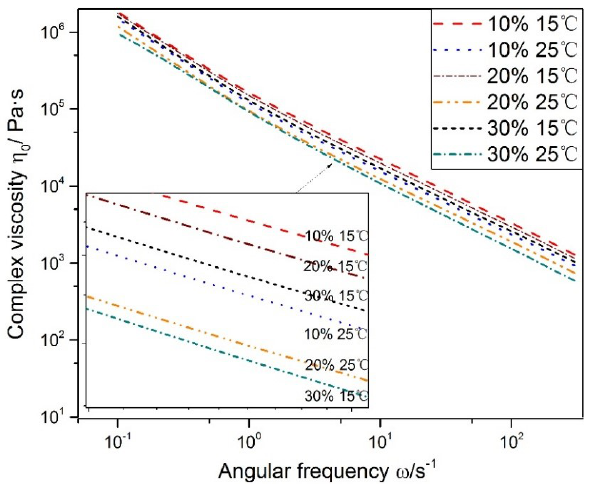
Figure 2: Complex viscosity against angular frequency dependence for RDX of various concentrations at different temperatures (The concentration of solvent was 1 mL/g).